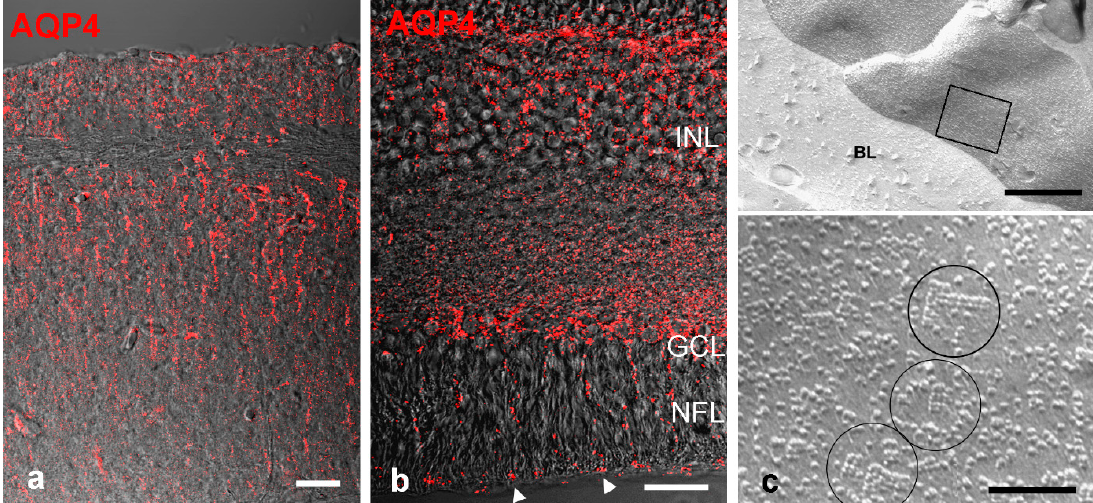
Figure 3. AQP4 localization fish brain and retina. ( a ) Immunostain in the brain (optic tectum) of a zebrafish ( Danio rerio ). AQP4 is expressed along radial glial fibers, but not particularly enhanced at the brain surface nor around blood vessels; ( b ) In the retina of the cichlid fish Astatotilapia burtoni punctate stain for AQP4 is detected along Müller cell fibers and endfeet at the inner limiting membrane (arrow heads); ( c ) Freeze fracture electron micrograph through Müller cell endfeet facing a basal lamina (BL). The square area shown at higher magnification in the lower panel reveals OAPs (circled). INL: inner nuclear layer, GCL: ganglion cell layer, NFL: nerve fiber layer. Scale bars 20 µm in ( a , b ), and 0.5 µm and 0.1 µm in ( c ).